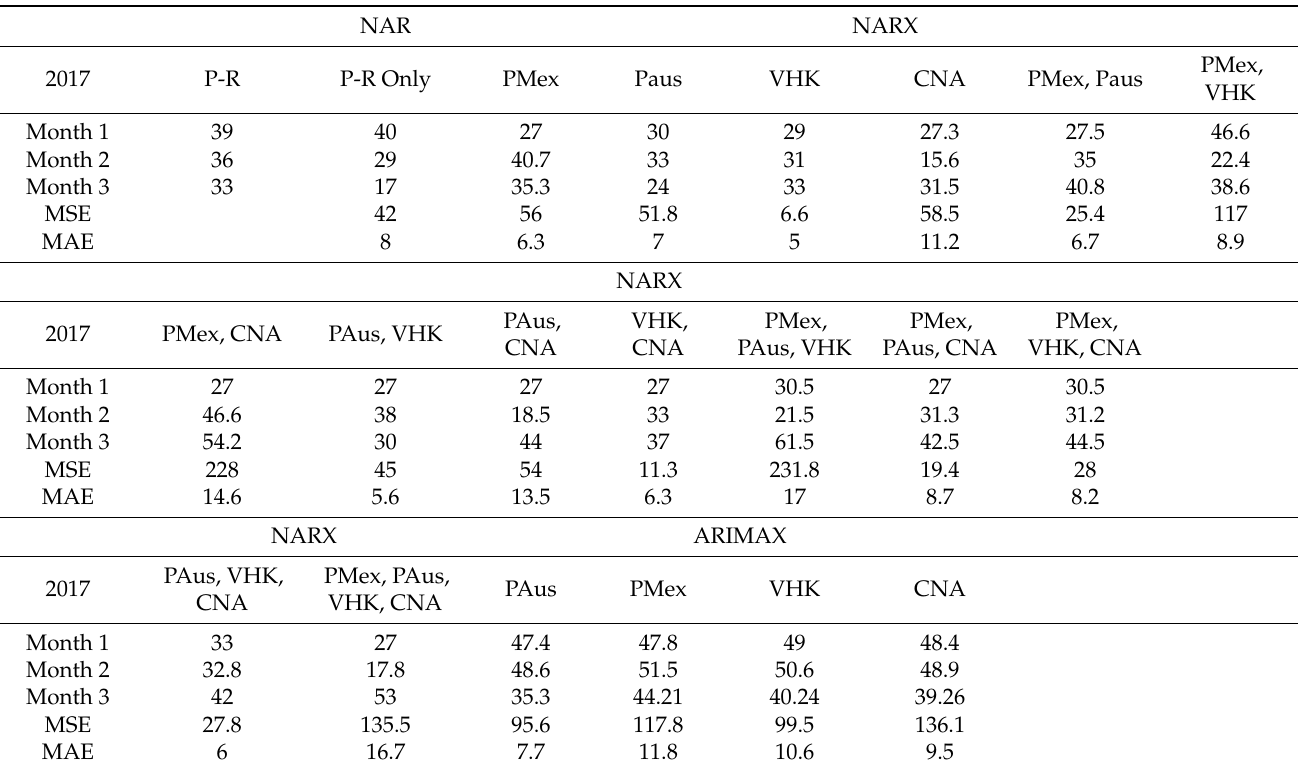
Table 4. Forecast of Mexican lobster export prices to China for the first three months of 2017. NAR